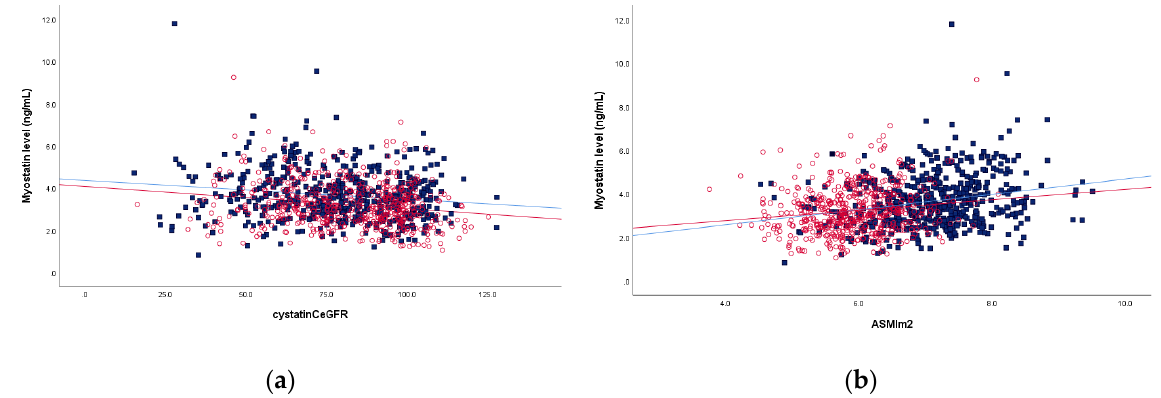
Figure 1. The correlations of myostatin level with cystatin C-based estimated glomerular filtration rate (eGFR) ( a ) and height-adjusted appendicular skeletal muscle mass (ASM) index ( (cid:4) male,